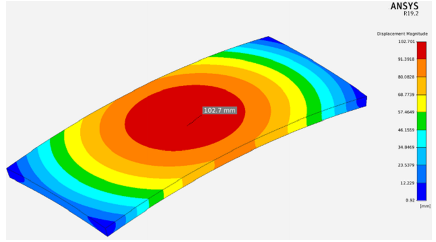
Figure 21. The residual stress on the surface of the 6061 aluminium alloy plate numerical